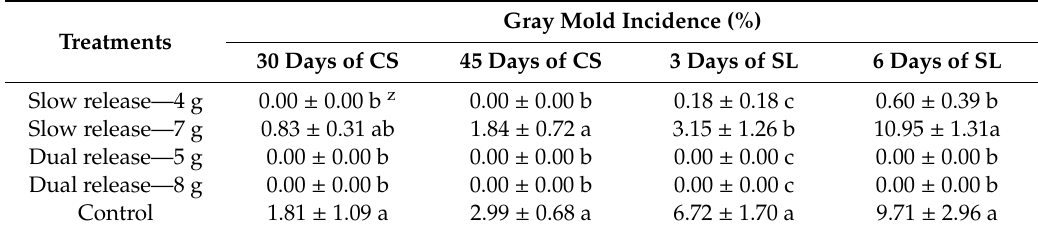
Table 1. Incidence of gray mold of clamshell-packaged ‘BRS Nubia’ seeded table grapes after 30 and 45 days of storage in cold storage (CS) at 1 ± 1 ◦ C followed by 3 and 6 days at shelf-life (SL) at 22 ± 1 ◦ C after the period of cold storage, packaged with di ff erent SO 2 -generating pads. Gray Mold Incidence (%) Treatments